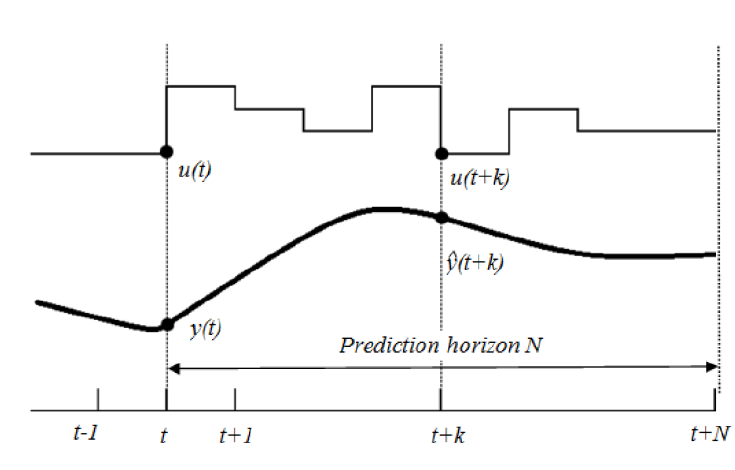
Figure 4. Strategy of